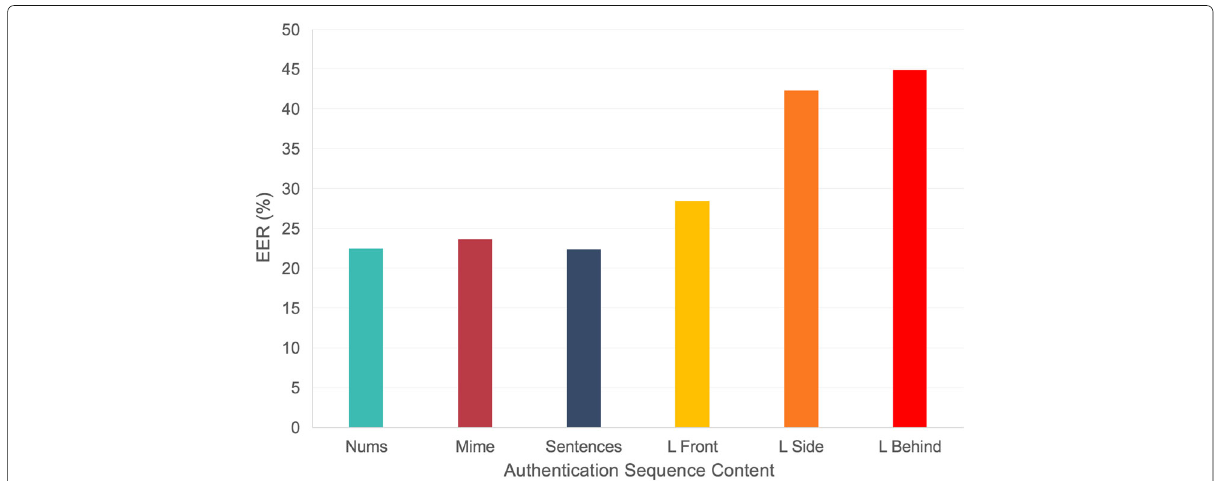
Fig. 10 Results from LipAuth trained with XM2VTS data on the FAVLIPS dataset